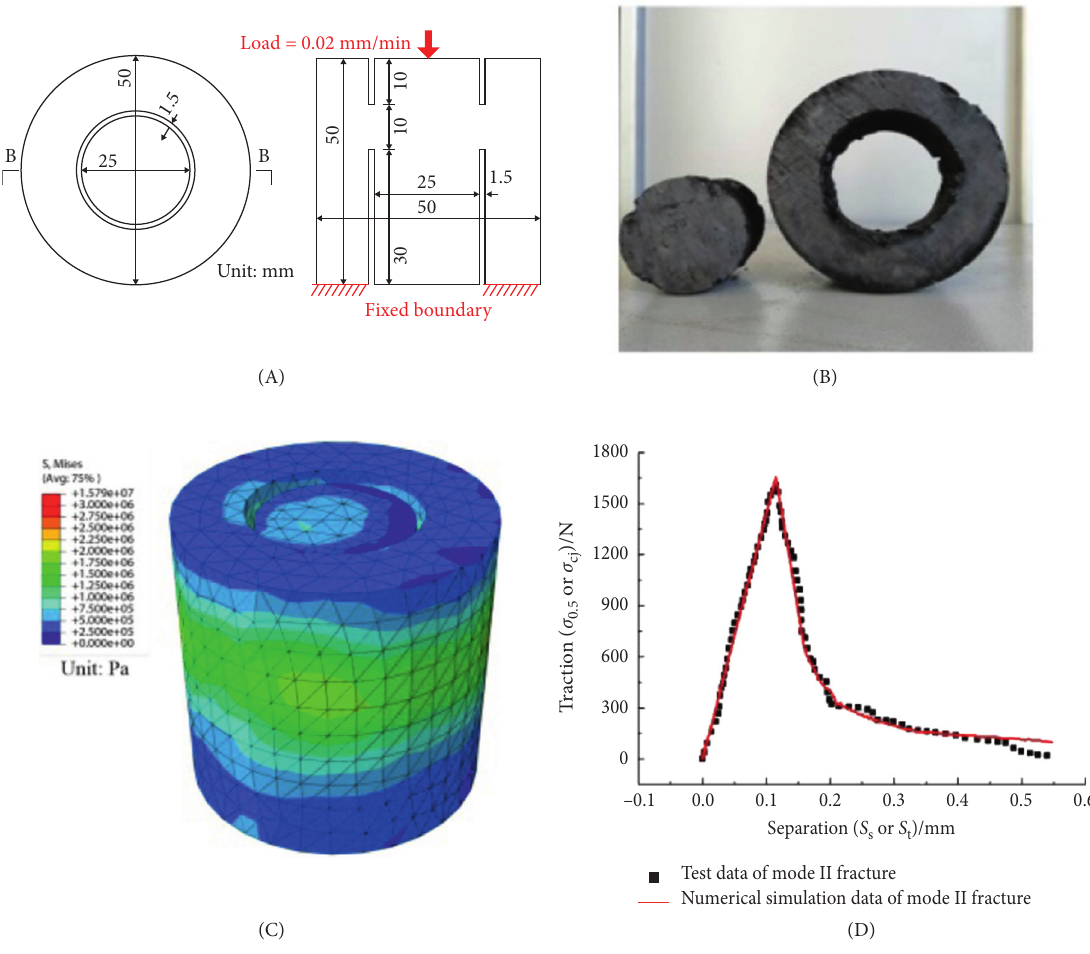
Figure 6: Numerical simulation and experimental results. (a) Numerical simulation and experimental results of mode I fracture. (A) Size of a specimen or numerical model with mode I fracture. (B) Specimen and fracture pattern of test [2]. (C) Fracture pattern from numerical calculation. (D) Comparison of traction-separation curves obtained by two methods. (b) Numerical simulation and experimental results of mode II fracture. (A) Size of a specimen or numerical model with mode II fracture. (The left one is the top view, and the right one is the B-B section. (B) Specimen and fracture pattern of laboratory test [2]. (C) Numerical calculation model and fracture pattern. (D) Comparison of traction-separation curves obtained by two